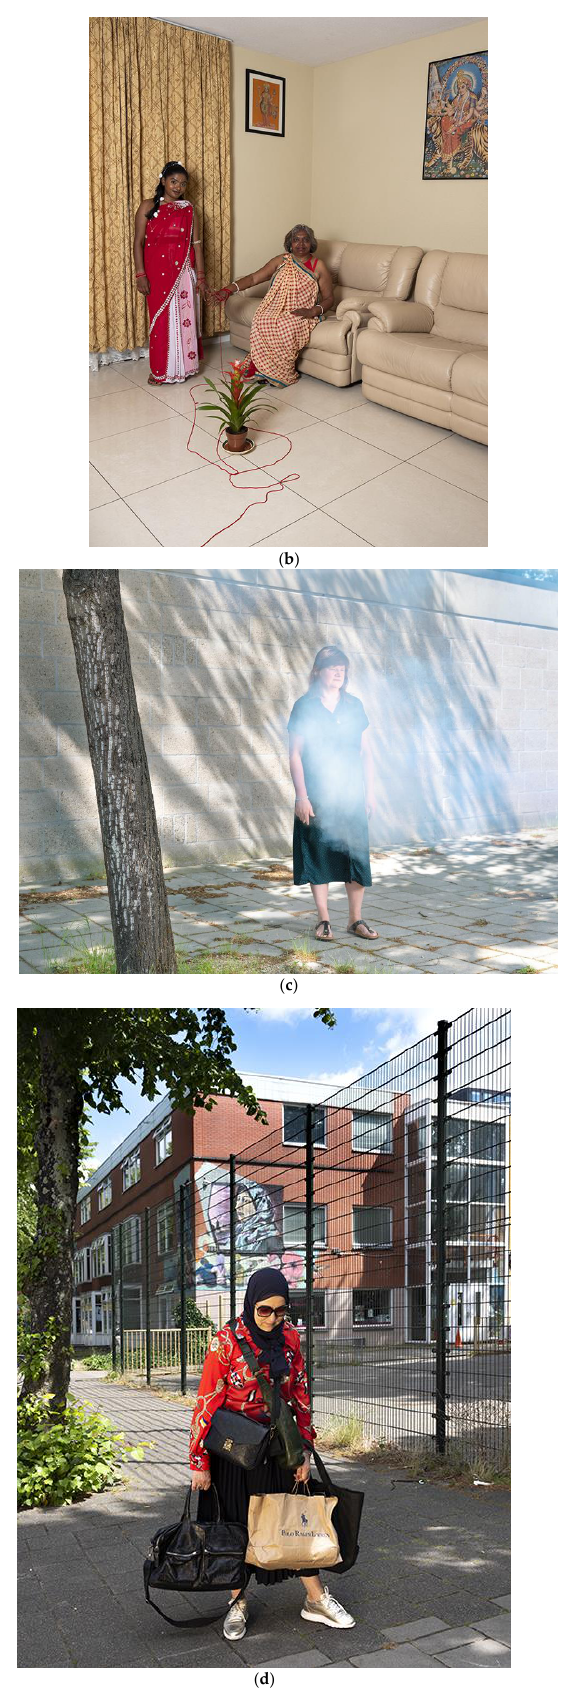
Figure 8. ( a – d ) Portraits of community researchers in book “ What You Don’t See ” .